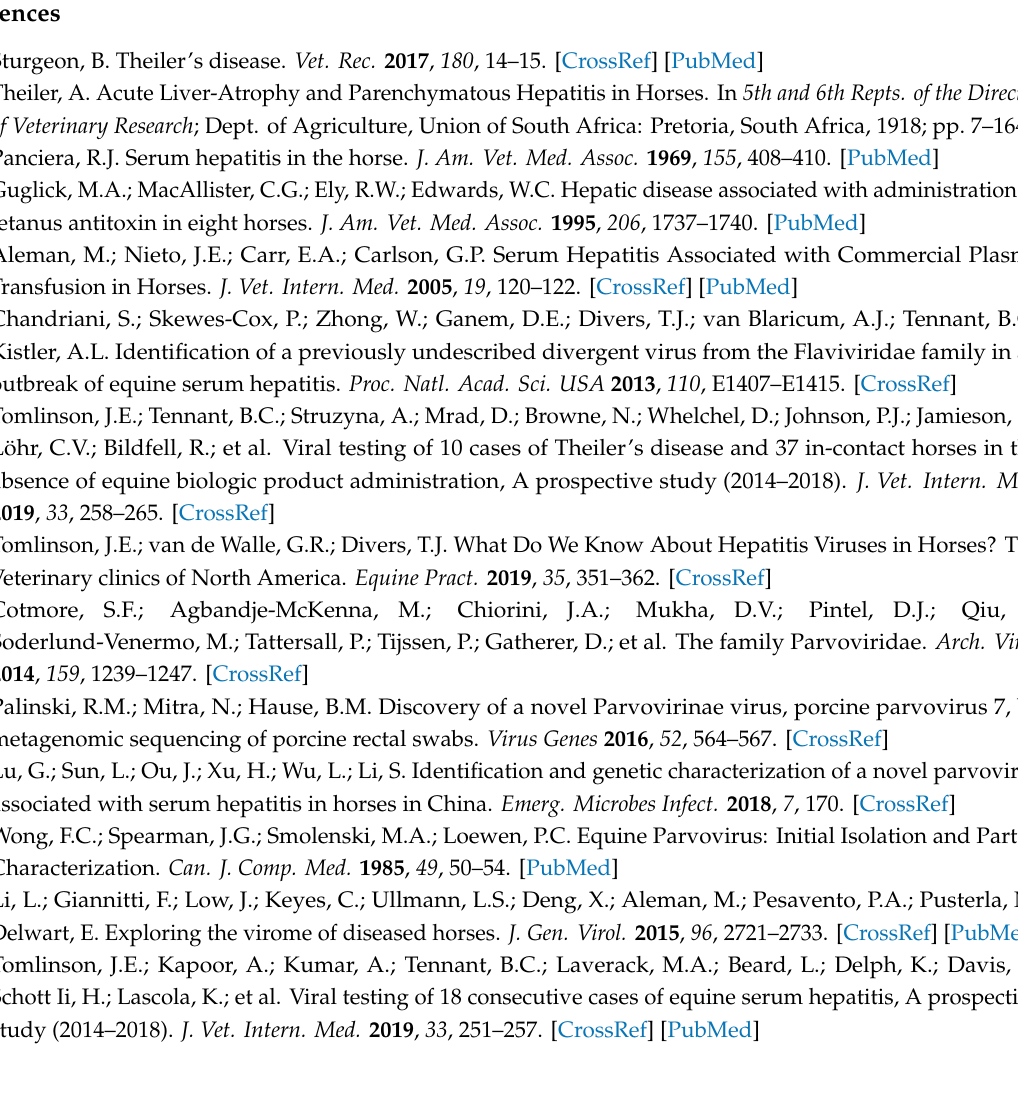
Figure S1: Correlation between EqPV-H and EqHV status of thoroughbreds. The EqPV-H status is displayed on the abscissa with the EqHV status shown in four shades of grey. Data for EqHV RNA and seroprevalence were obtained during a previous study [18]; Figure S2: Postnatal serum samples from a foal and an EqPV-H-positive mare were evaluated for the presence of EqPV-H VP1 antibodies and DNA at the indicated times using a luciferase immunoprecipitation (LIPS) assay and the relative increase of RLU compared to an EqPV-H-negative control sample was